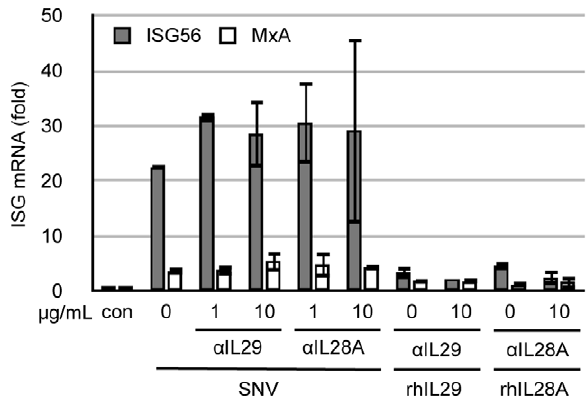
Figure 5. Endothelial cells specifically respond to SNV and are refractory to IFN l . HUVEC were treated with SNV at an MOI=1 (50 m L of stock virus), rhIL29 (50 ng/mL), rhIL28A (50 ng/mL), or left untreated (con) with or without pre-incubation with the indicated neutralizing antibody for 1 h. Cellular RNA was used to quantitate ISG expression 3 h post exposure. Real-time qRT-PCR results are reported as the mean 6 SEM from triplicate biological experiments.